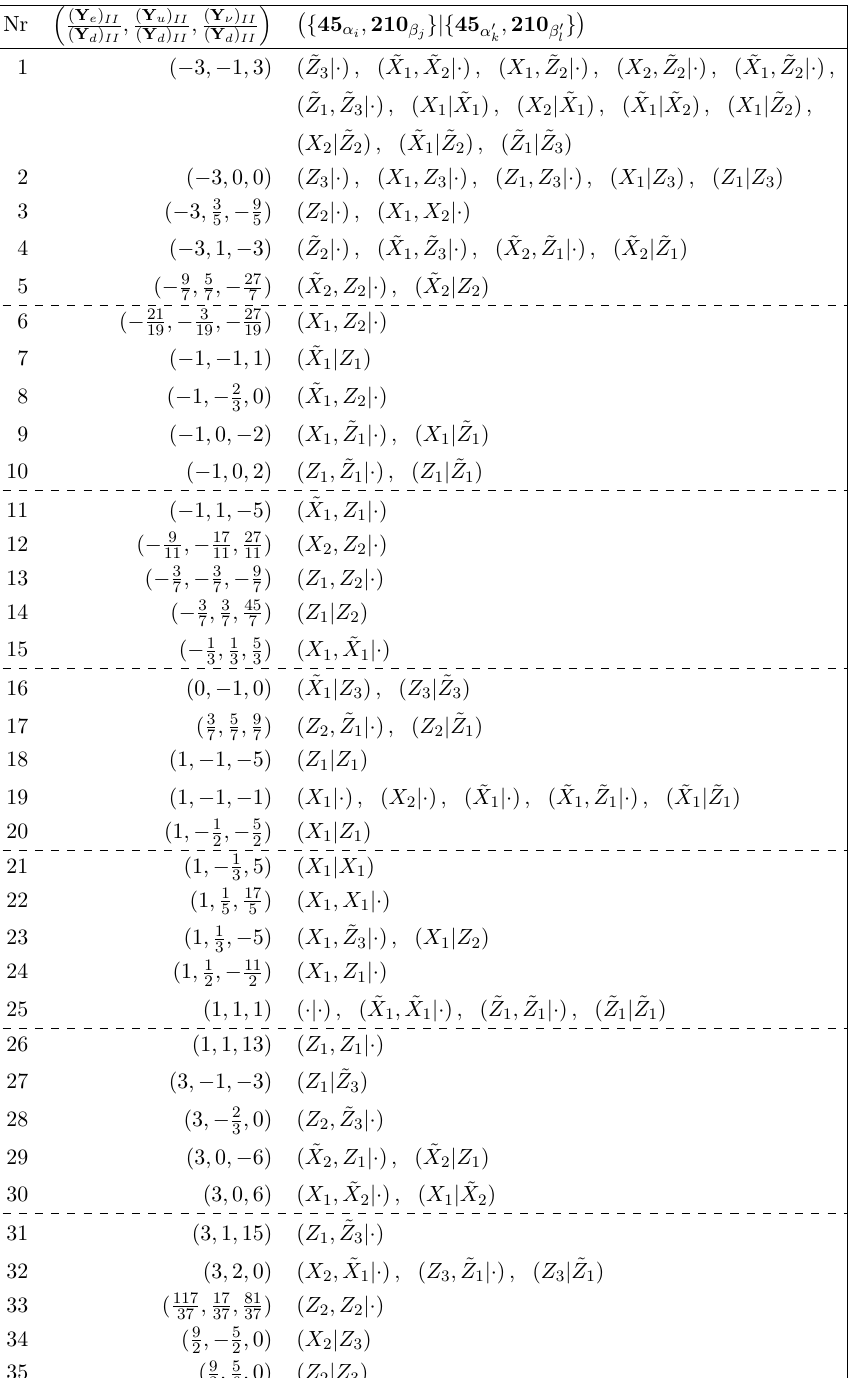
; 210 (cid:12) g on the left-hand side and i j